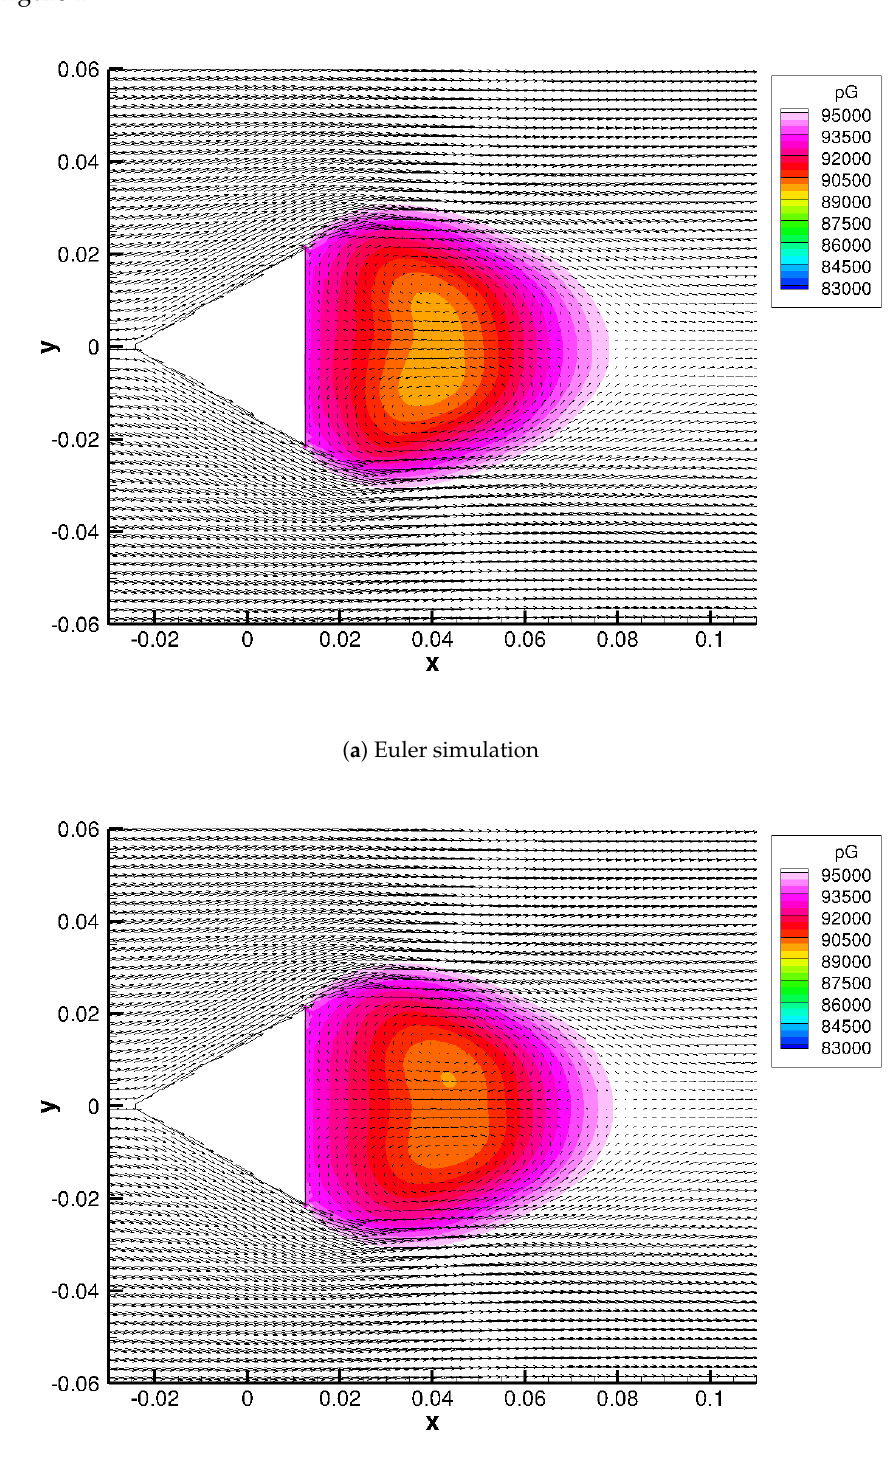
Figure 4. Time-averaged pressure contour and velocity vectors at the z = const. plane of the fine grid